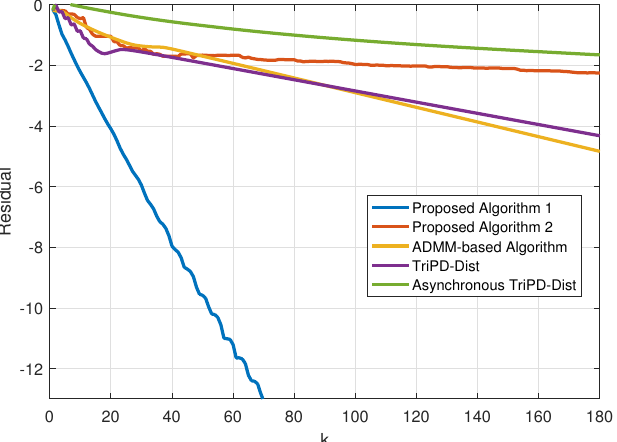
Figure 3. Performance